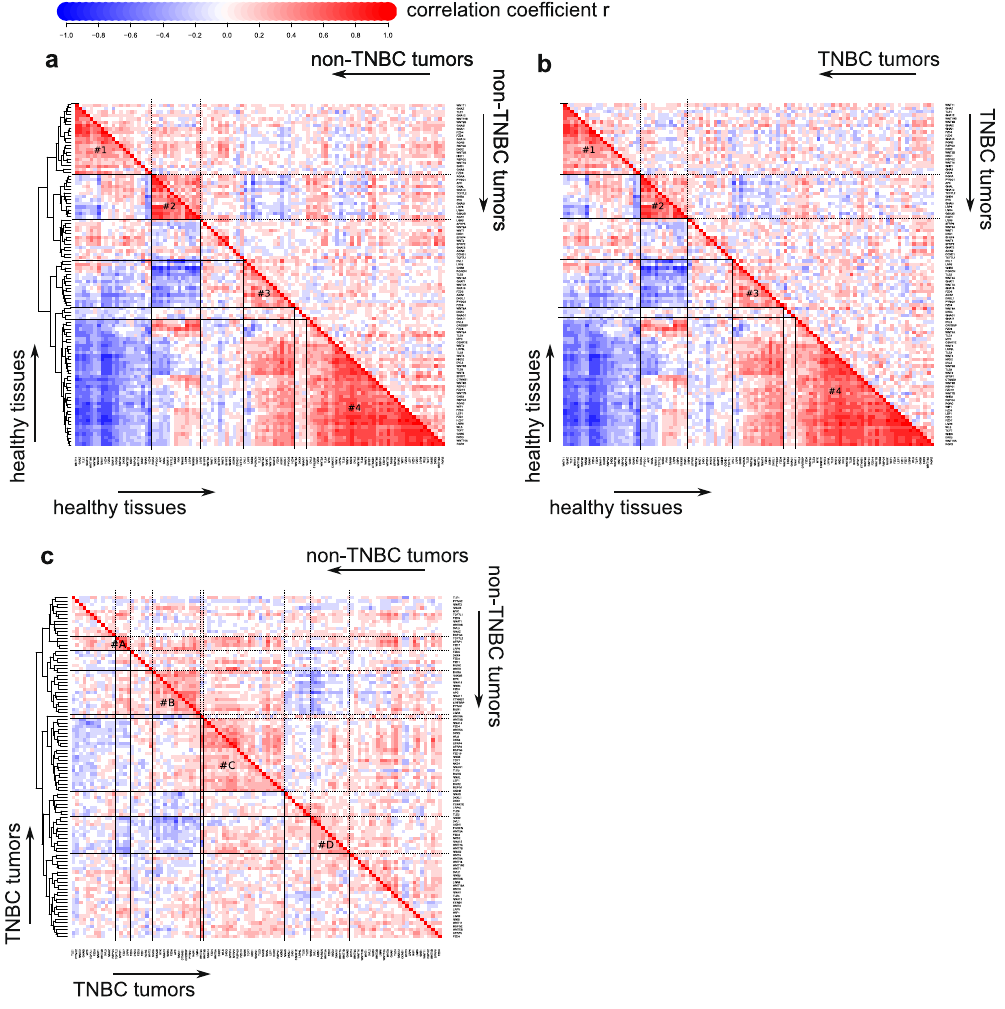
Figure 3. Comparison of the Wnt pathway components expression level correlations in healthy breast and breast cancer. Panel ( a ) shows clustering using the complete linkage algorithm for pairwise correlations in healthy breast (lower triangle of the heatmap) and for those observed in non-TNBC samples (upper triangle). The correlation clusters are highlighted by lines and numbered; the cluster #2 is the only one which can be observed in non-TNBC tumors (shown in dashed lines in the upper triangle). Panel ( b ) is similar to panel (a) but shows correlations in TNBC tumors in its upper triangle. Note that cluster #2 is also largely preserved. Panel ( c ) compares TNBC and non-TNBC tumors. Out of 4 gene clusters identified for Wnt component genes in TNBC, 3 (#A, #B and #C) are somewhat paralleled in non-TNBC (dashed